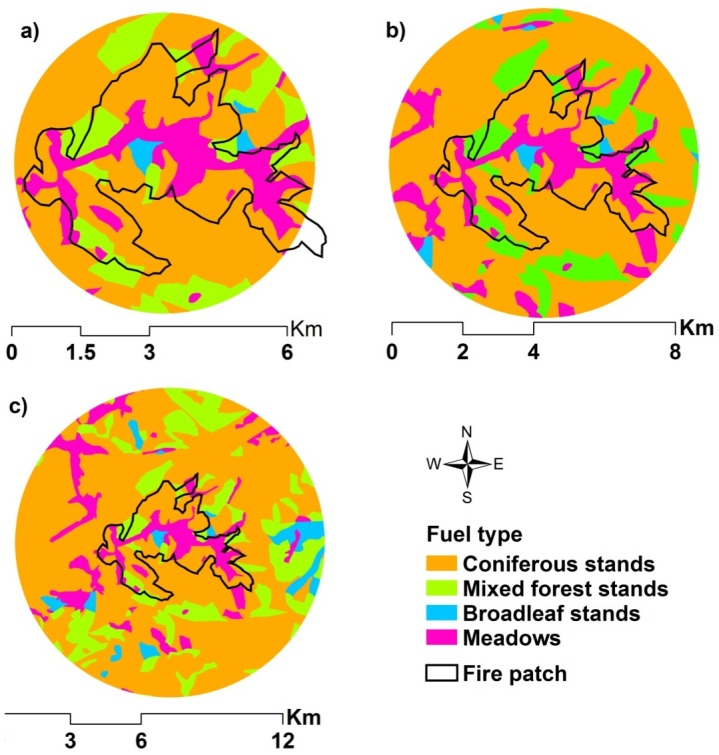
Schematic representations of a fires and its “neighborhood”.A “neighborhood” was defined as twice (a), 4 (b), and 8 (c) times the size of the actual fires patch, respectively.